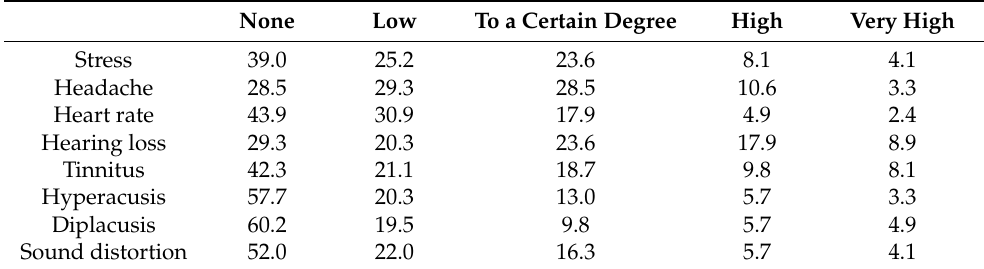
Table 4. Percent of respondents expressing the level of concern with health effects among marching band